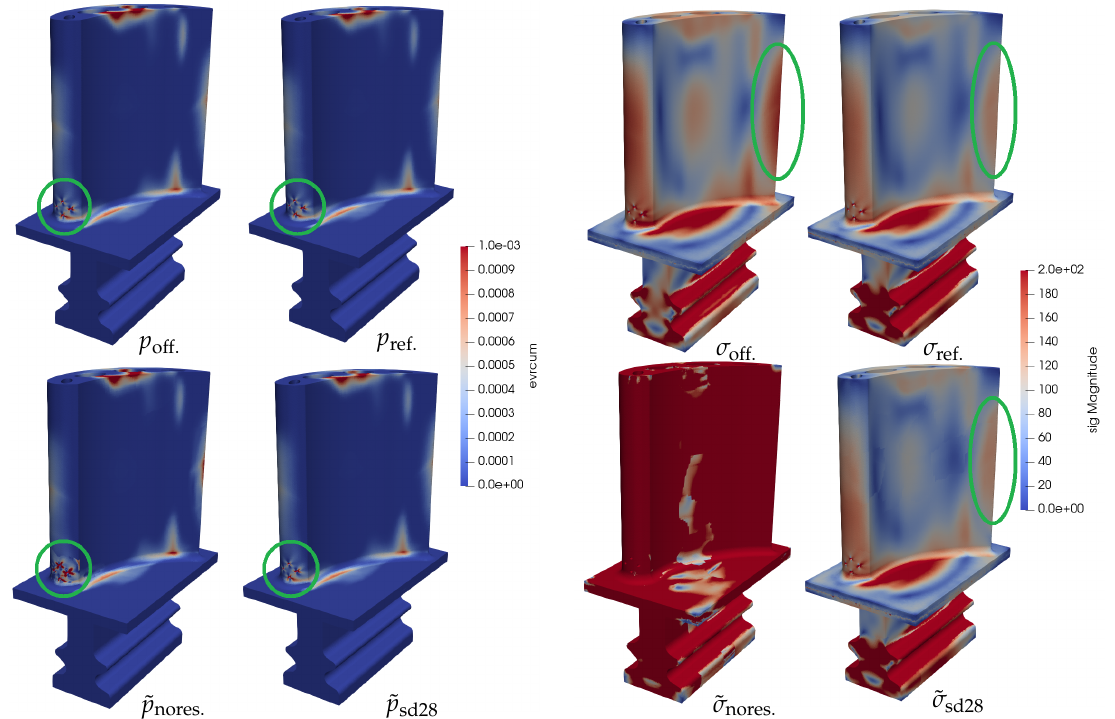
Figure 14. Complete ROM dual quantity fields at t = 43.5 s, with enrichment by monitoring subdomain 28. ( left ) Cumulated plasticity; ( right ) magnitude of the stress